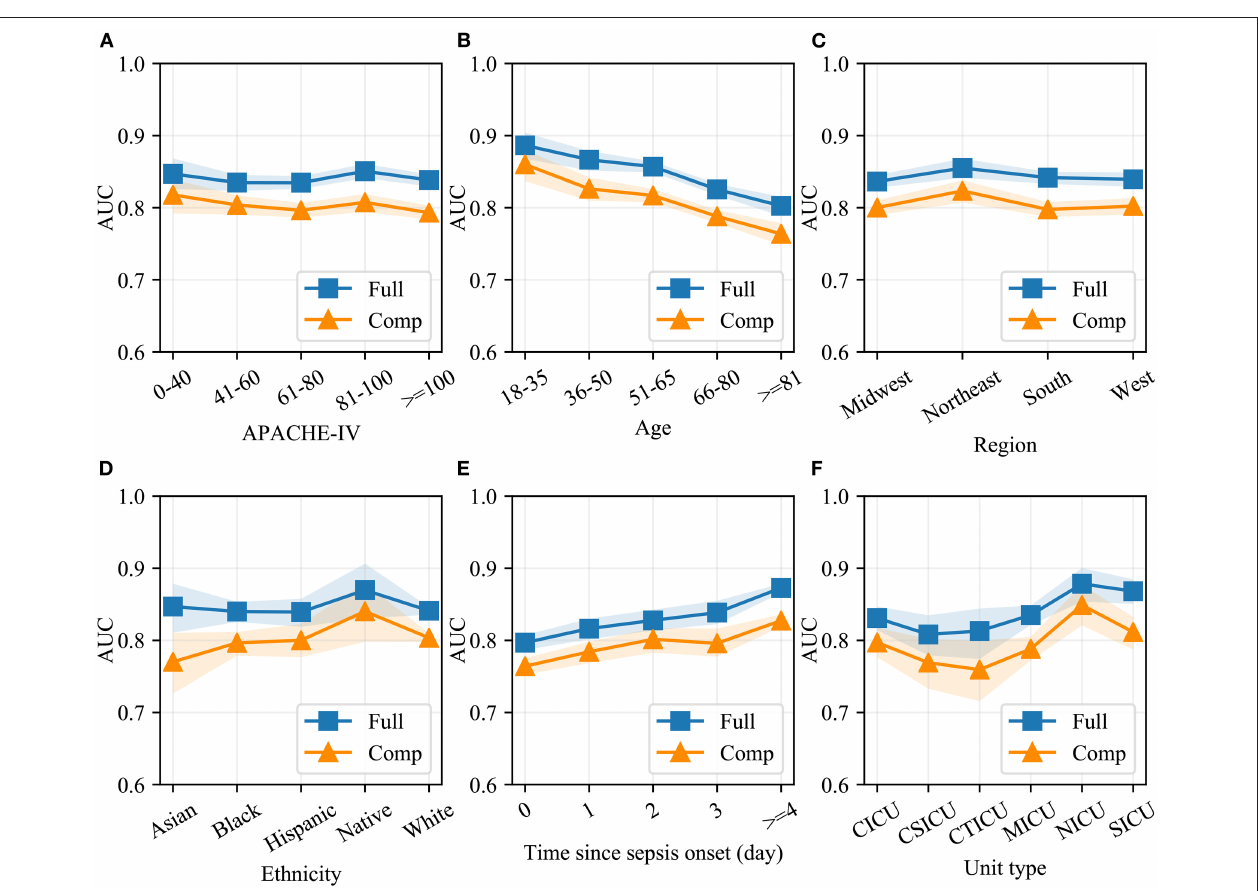
FIGURE 5 | Model performance in different patient cohorts in eICU-CRD. Different validation sets were derived based on APACHE-IV (A) , age (B) , region of the United States (C) , ethnicity (D) , time since sepsis onset (E) and unit type (F) . AUC of the full and the compact models in each set was measured using the Bootstrap Resampling technique. The colored area represents 95% confidence intervals. Full, the full model; Comp, the compact model; AUC, area under receiver operating characteristic curve; APACHE-IV, Acute Physiology and Chronic Health Evaluation-IV; CICU, cardiac intensive care unit; CSICU, cardiac surgical intensive care unit; CTICU, cardiothoracic intensive care unit; MICU, medical intensive care unit; NICU, neuro intensive care unit; SICU, surgical intensive care